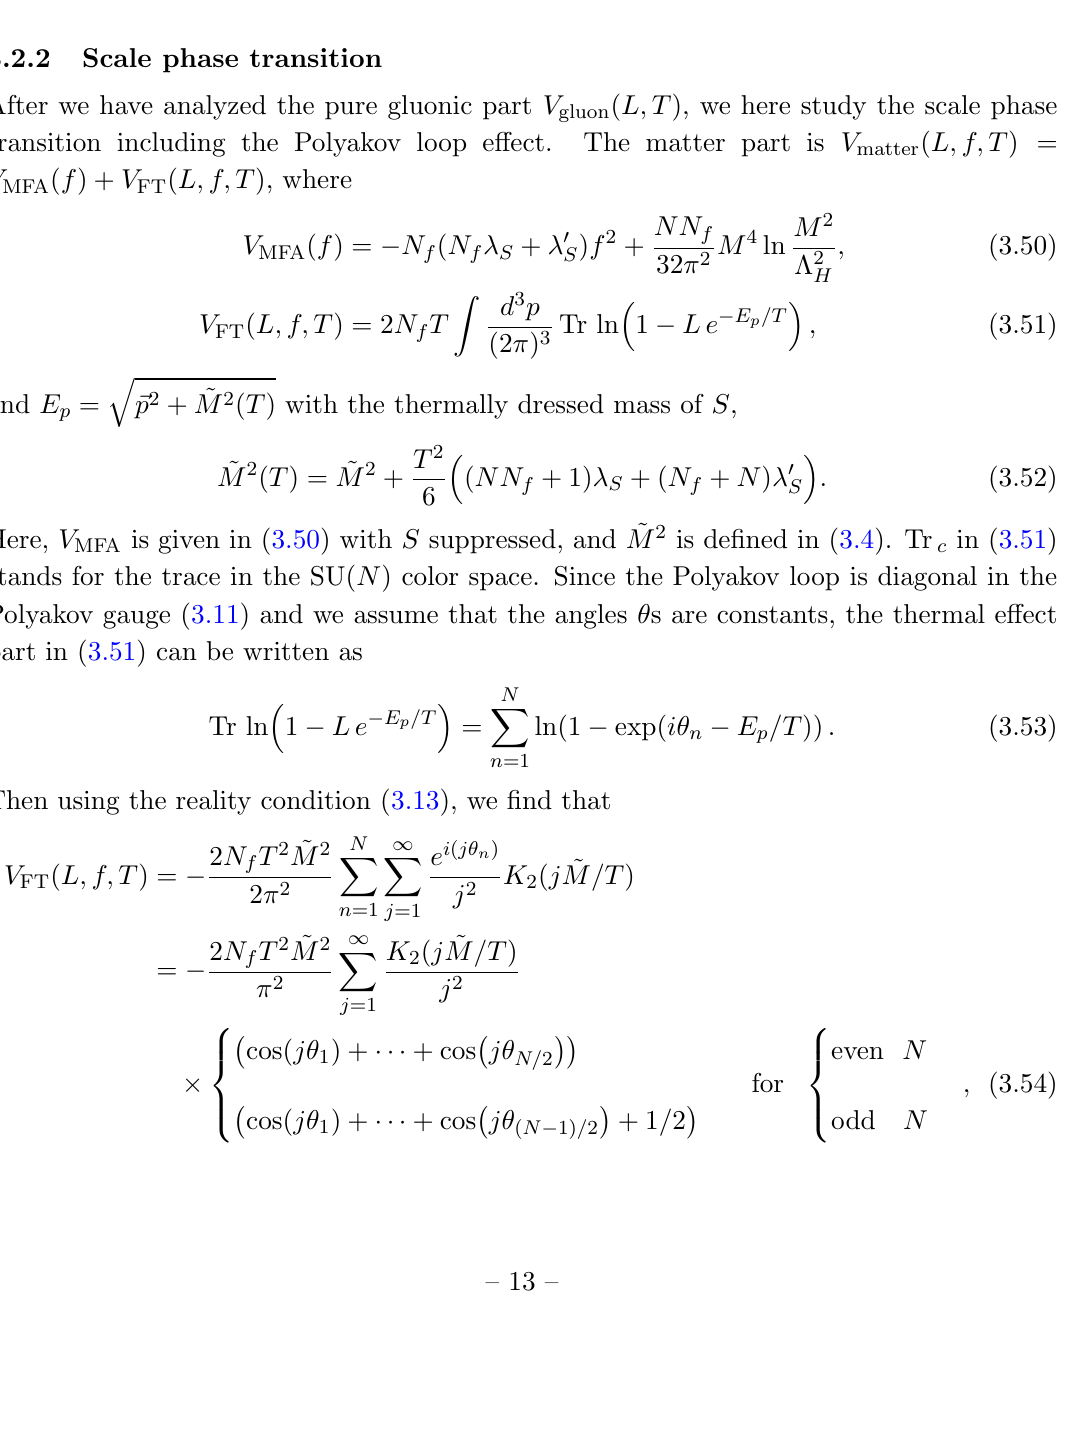
Figure 5 . The potential V gluon ; 6 ( L; T ) =b 6 T at ~ a c = 2 : 06064 as a function of ‘ (left) and j z j (right) on the three di(cid:11)erent lines c 1 (red), c 2 (blue), c 3 (black) linking the two minimum points given in (3.43) and